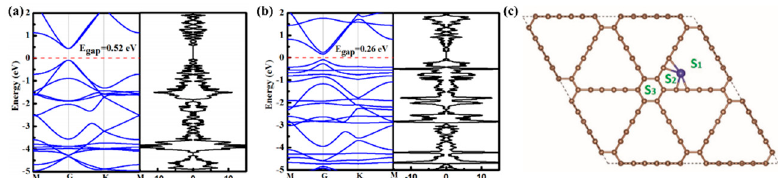
Figure 12. Band structures of the pristine and the TM-atom anchored GDY and di ff erent possible adsorption sites for the single TM-atoms supported on GDY. Electronic properties of band structures and density of states of ( a ) GDY monolayer and ( b ) Ni@GDY composite. The Fermi level is set to zero; ( c ) di ff erent possible adsorption sites for the single TM atoms supported on GDY: at the center of the holes (S1), at the corner of the holes (S2) and at the center of hexatomic ring (S3). (reproduced with permission from [123]. Copyright Wiley-VCH,